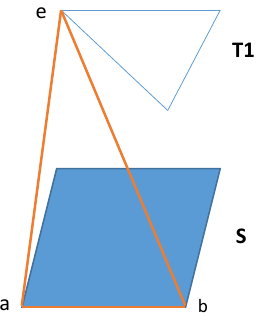
Figure 11. Identification of Parallel and Coplanar Triangles.